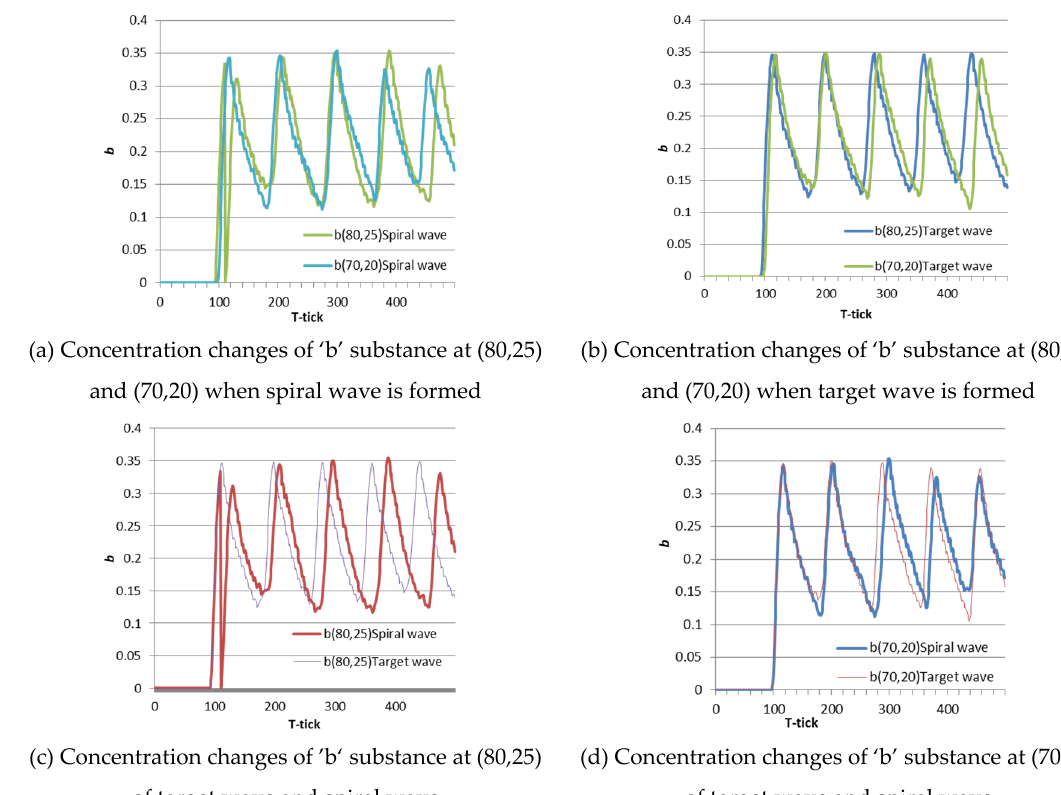
Figure 11. The concentration changes of ‘b’ with time at points (70,20) and (80,25) and compared with changes in the target wave concentration at the same time and at the same location. Disturbance is added at 300 time steps.